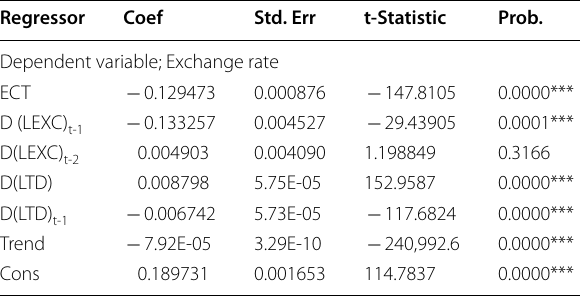
Table 7 Short-run estimates based on PMG for China